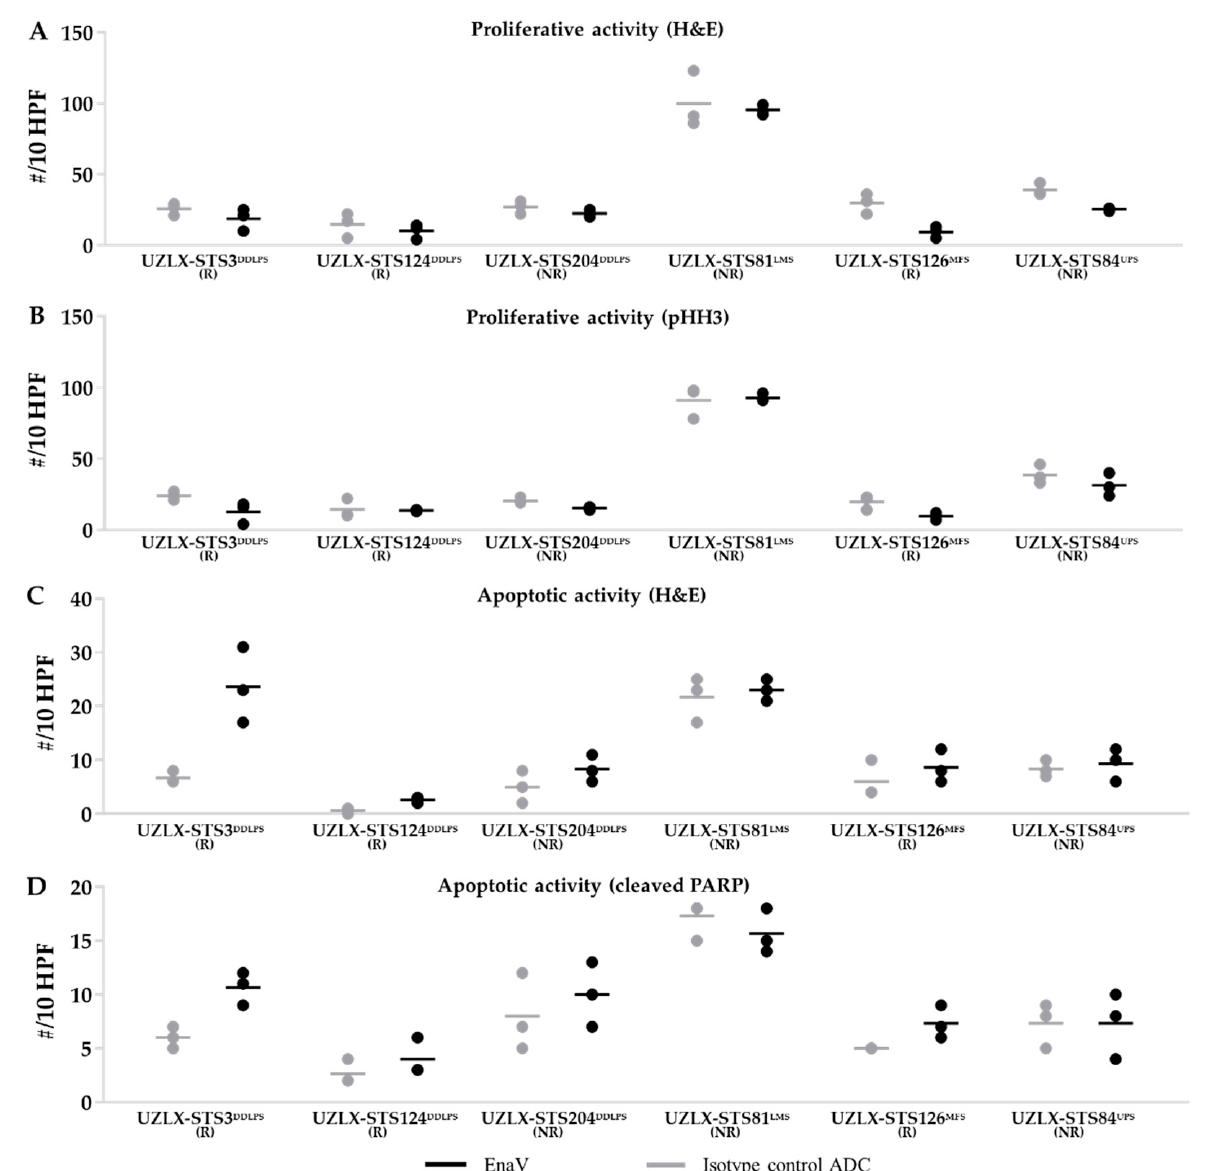
Figure 4. Assessment of mitotic and apoptotic activity of tumors (n = 3) collected on day 22. Mitotic cell count assessed on ( A ) H&E and ( B ) pHH3 staining. Apoptotic cell count assessed on ( C ) H&E and ( D ) cleaved PARP staining. Data are presented as average ± standard deviation. Samples from UZLX-STS84 UPS and -STS128 LMS could not be assessed, as EnaV-treated tissues were too small to count 10 HPF. HPF: high power fields; H&E: hematoxylin & eosin; pHH3: phospho-histone H3; PARP: poly (ADP-ribose) polymerase; R: responding model; NR: non-responding model.